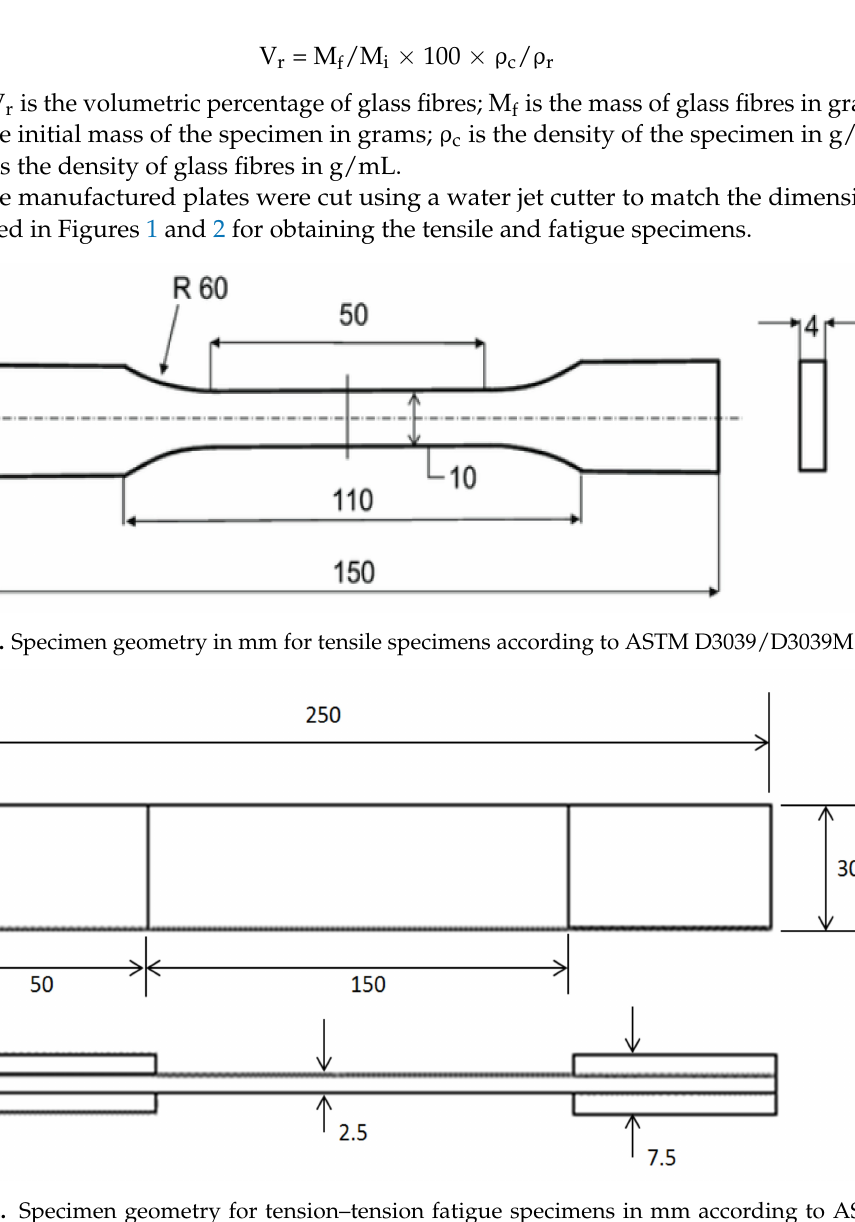
Figure 2. Specimen geometry for tension–tension fatigue specimens in mm according to ASTM